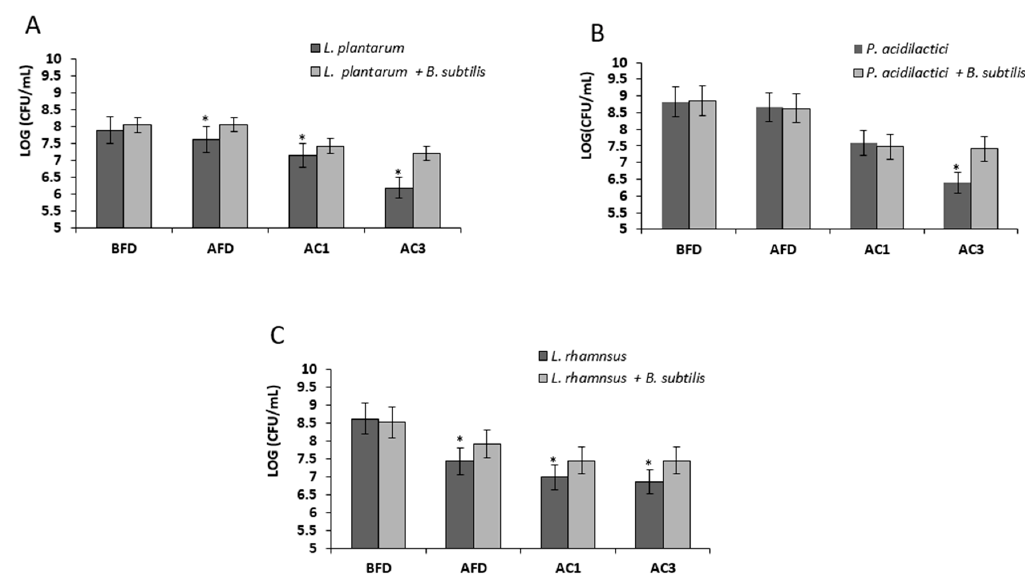
Figure 5. Bio-coating increases the survivability of the LAB during acid stress following freeze-drying. Mono- and dual-species cultures of B. subtilis and the LAB cells were generated in MMRS medium during bacterial growth for 8 h in 37 °C , 50 rpm. Survival rates of LAB cells were determined based on CFU counts following freeze-drying and an exposure to low pH (HCl 1 M, pH = 2) for 1–3 h. * p < 0.05 for comparison of the control and tested samples. Error bars represent standard deviation (SD). BFD—before freeze-drying; AFD—after freeze-drying; AC1—freeze-dried and exposed for 1 h to acid conditions; AC3—freeze-dried and exposed for 3 h to acid conditions. The survival rates are shown for ( A ) L. plantarum , ( B ) P. acidilactici , and ( C ) L.